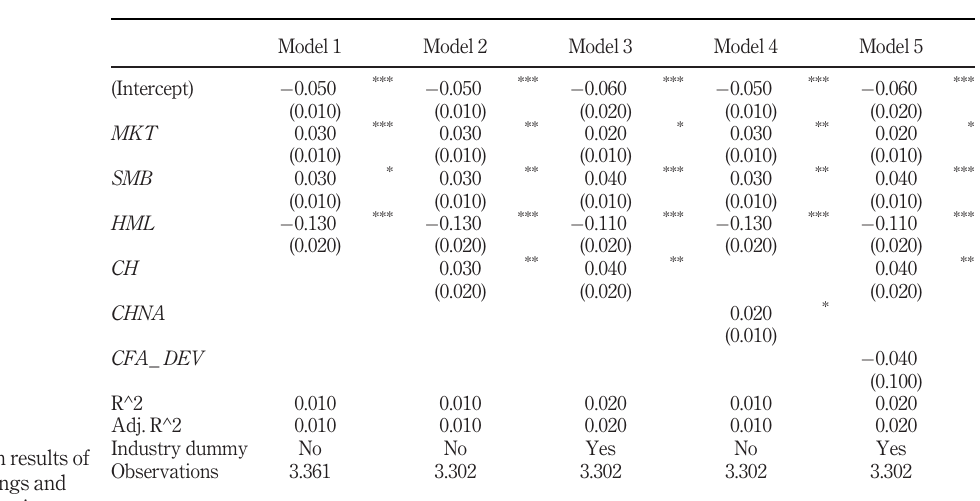
Table 5. Regression results of cash holdings and expected equity